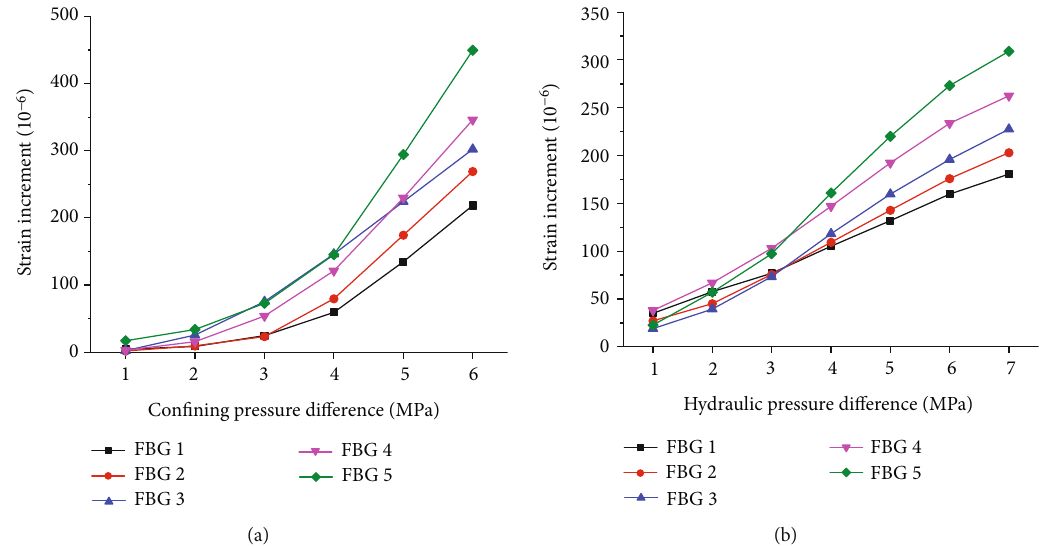
Figure 13: Strain monitoring results of microfracture surface with JRC = 4~6 : (a) relationship between strain measured at di ff erent points and con fi ning pressure di ff erence and (b) relationship between strain measured at di ff erent points and hydraulic pressure di ff